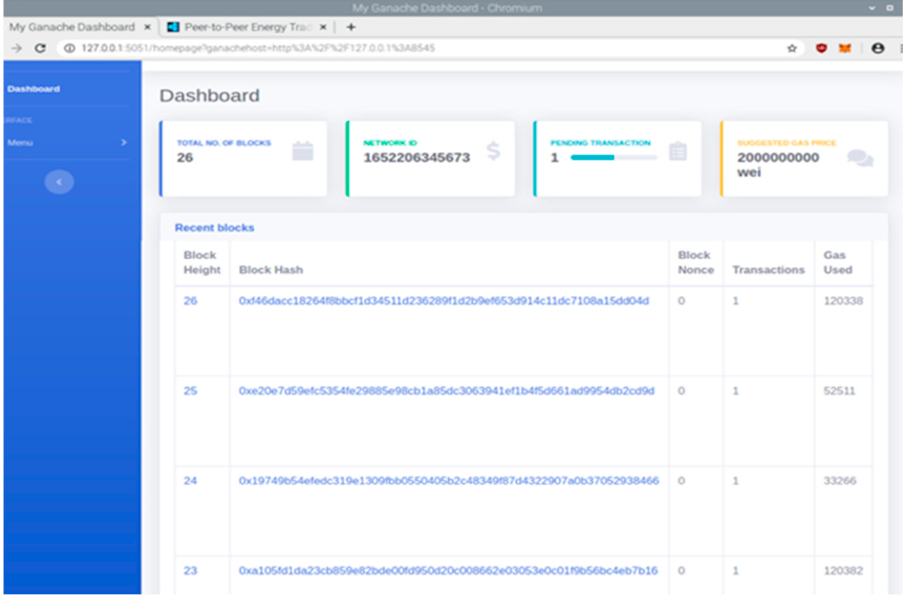
Figure 12. Blockchain Server.